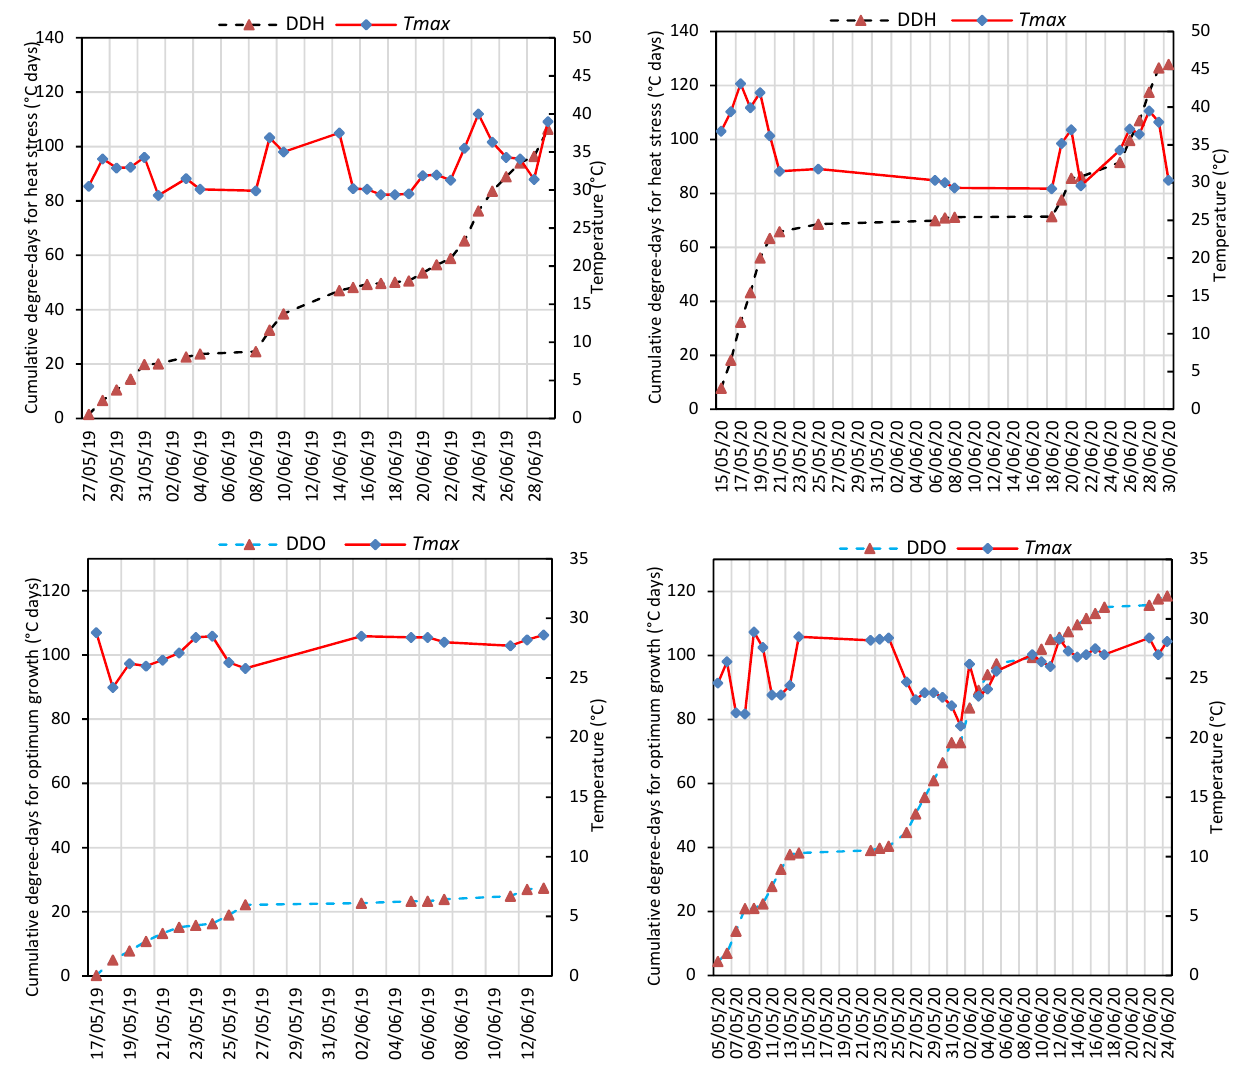
Figure 2. Cumulative degree-days for heat stress (DDH) and optimum growth (DDO) according to heat threshold temperature (29 °C) and daily maximum temperatures ( T max ) during flowering and pod setting stages in the 2019 and 2020 growing seasons.